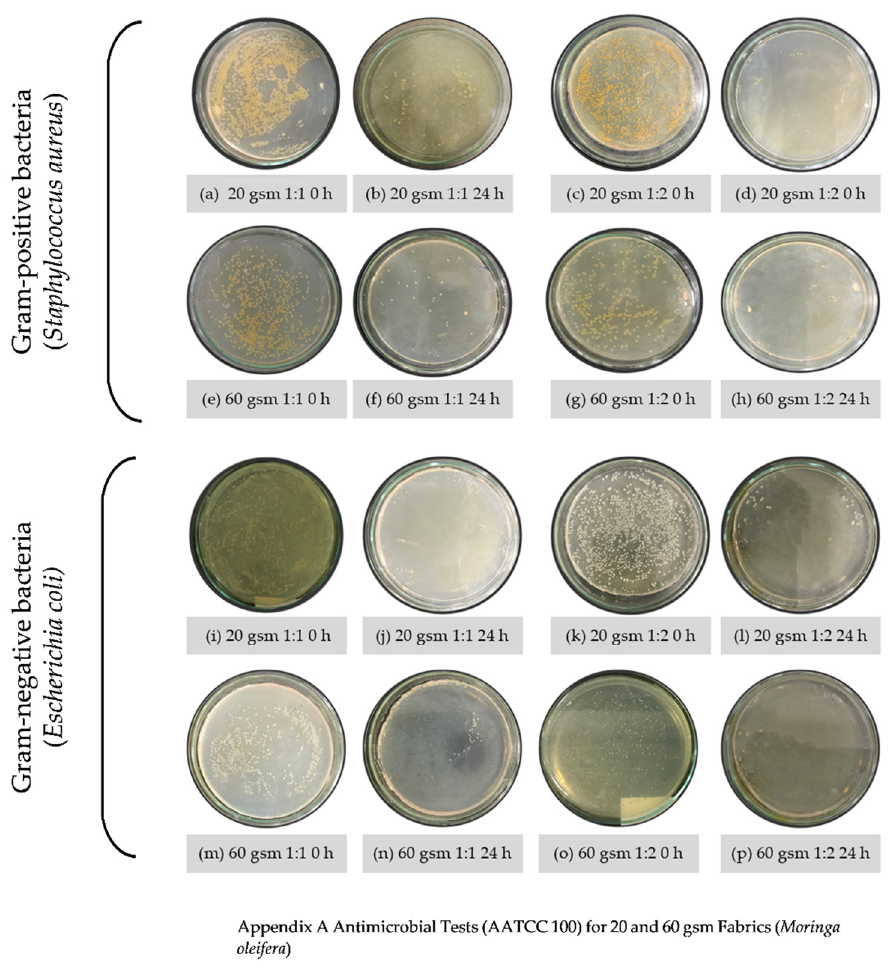
Figure A1. Chemical Constituents, Phytoconstituents and Compounds and Present in Moringa oleifera, Aegle marmelos, and Murraya koengii (curry leaf), and Coconut oil Using GC-MS